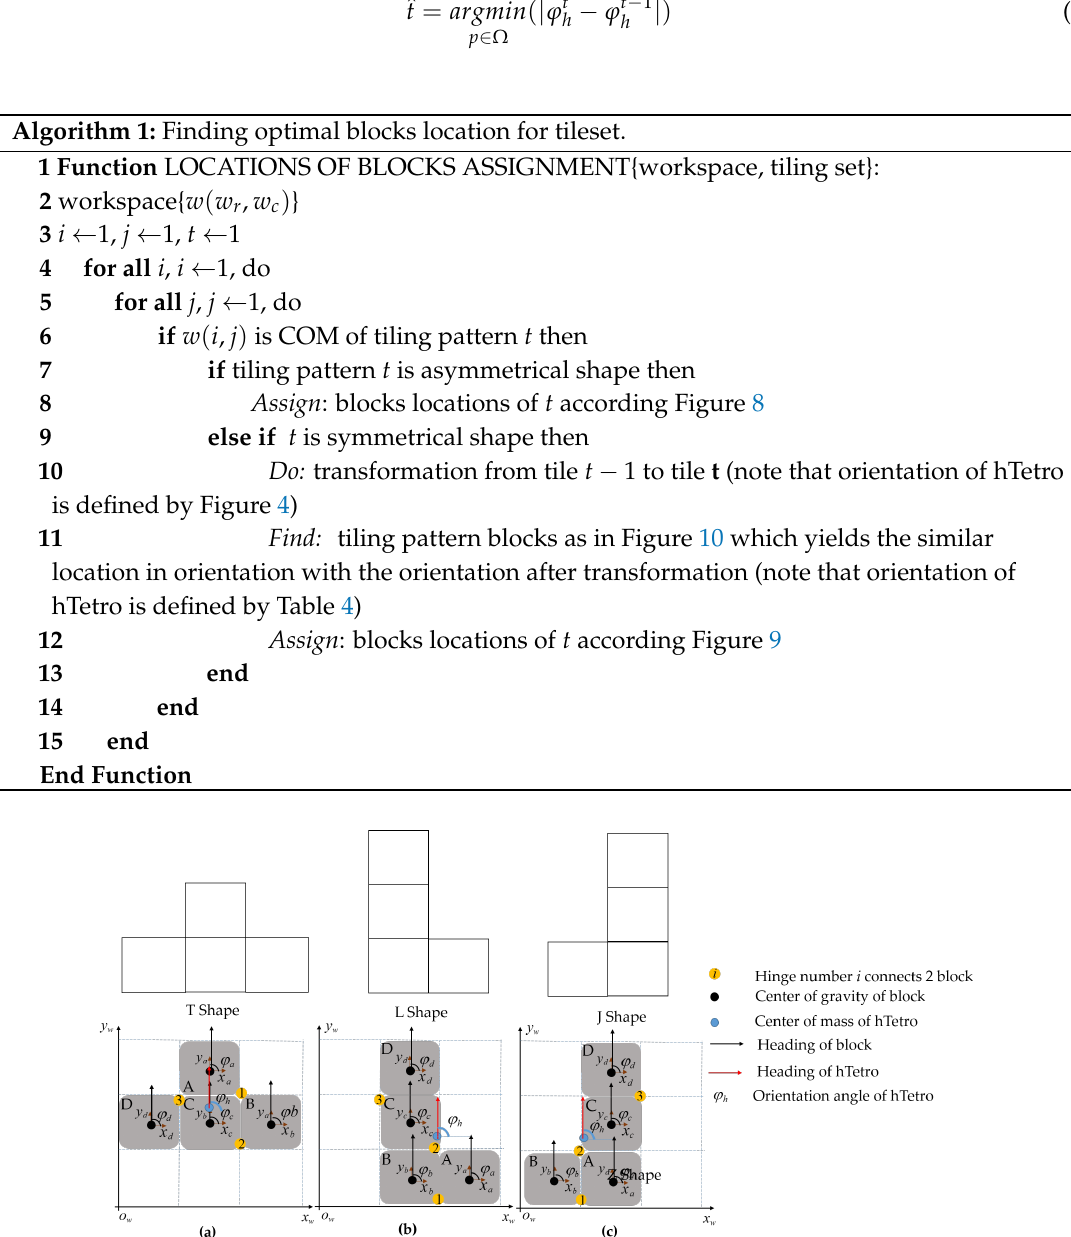
Figure 8. Blocks location option for asymmetric shape. ( a ) T morphology, ( b ) J morphology, ( c ) L